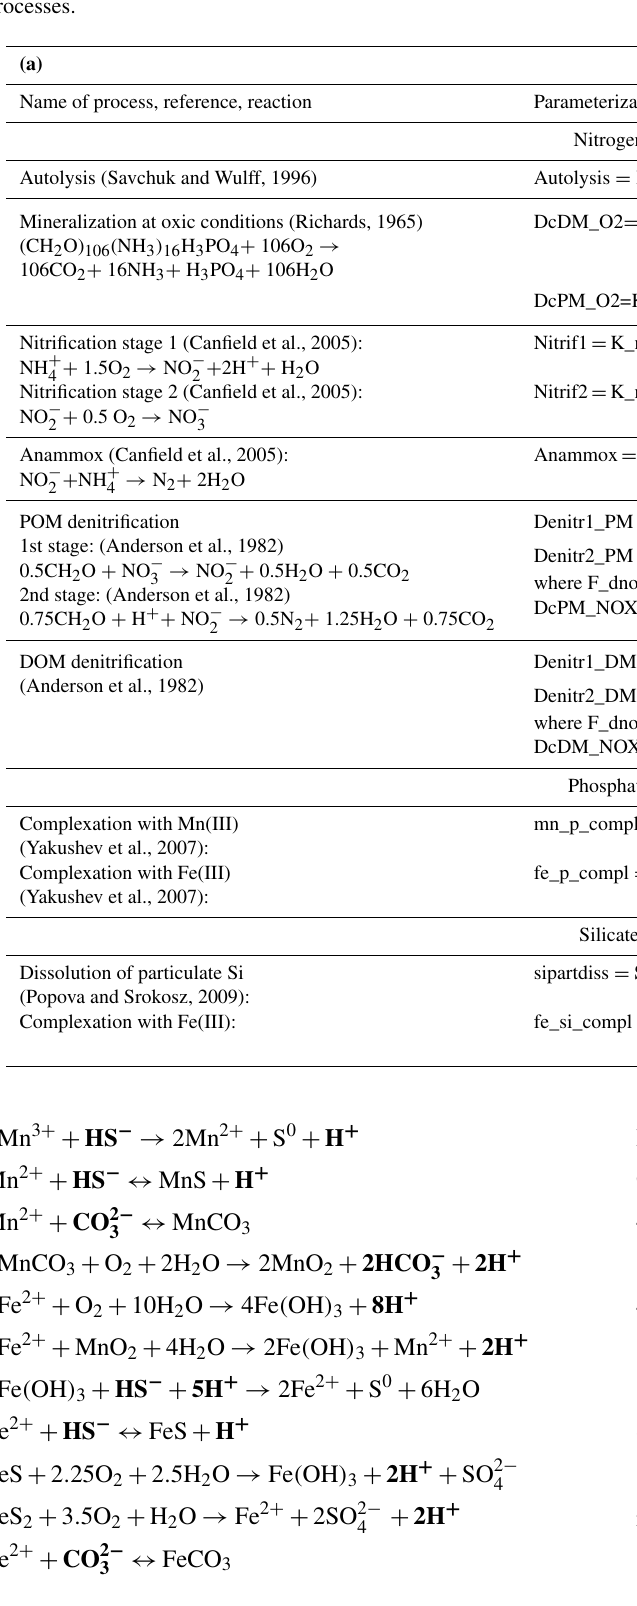
Table 2. Parameterization of the biogeochemical processes: (a) nutrients; (b) redox metals and sulfur; (c) carbon and alkalinity; (d) ecosystem